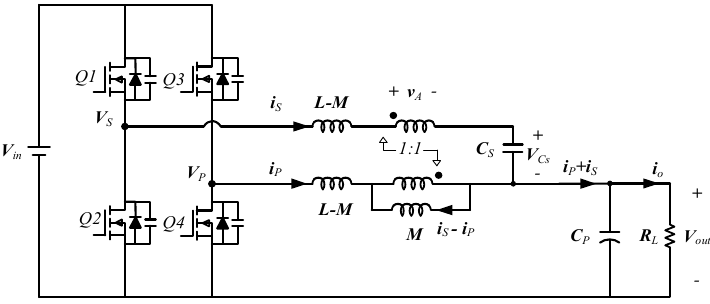
Table 1. Circuit parameters. Symbols